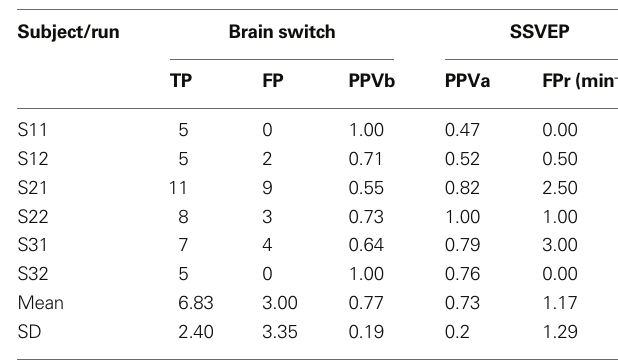
Table 2 | Results from our study involving a brain switch to turn on/off an SSVEP based orthosis.